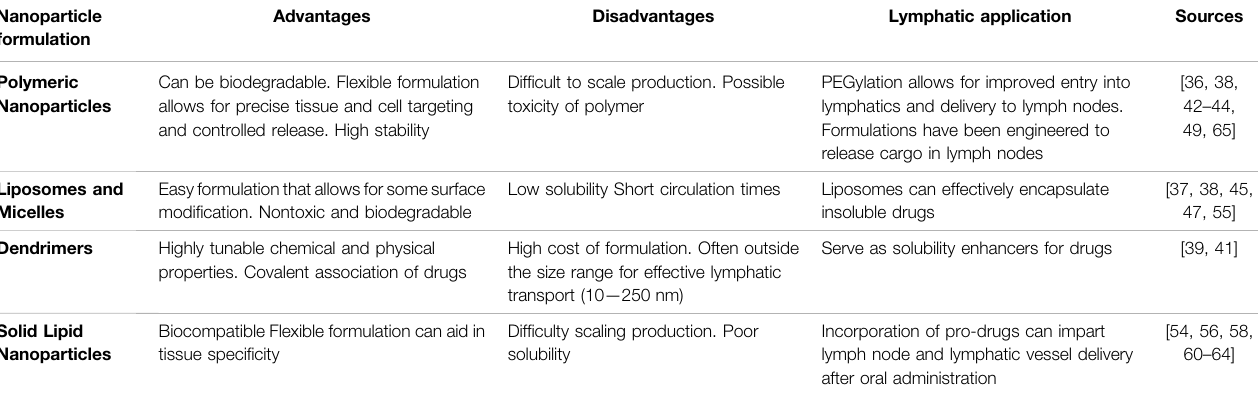
TABLE 1 | Summary of nanoparticle formulations used for lymphatic